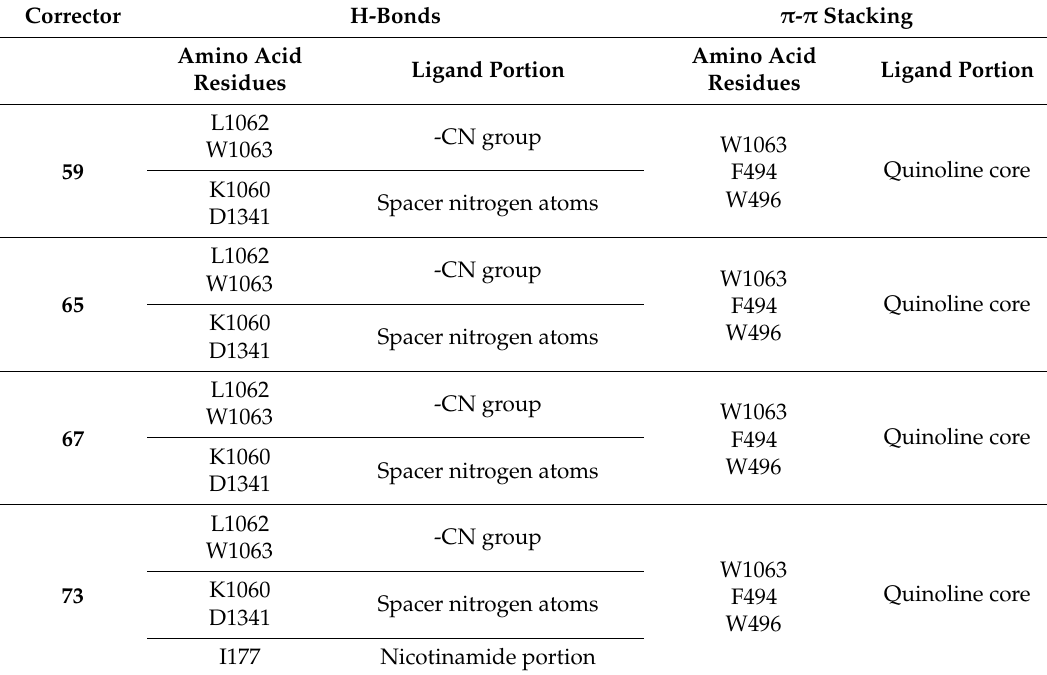
Table 4. Pattern of the most important interactions within the modelled F508del-CFTR protein observed for the most promising CQs, chosen as representative of this series of